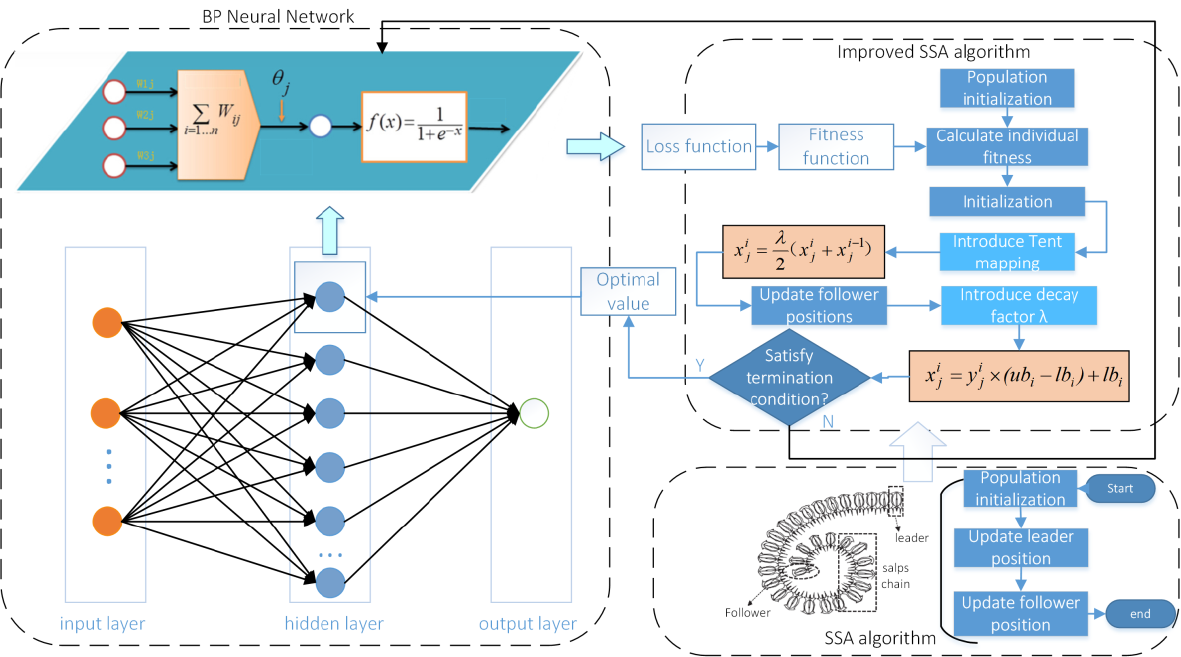
Figure 1. Overall idea frame diagram3.1. Introducing the improved algorithm of chaotic mapping.